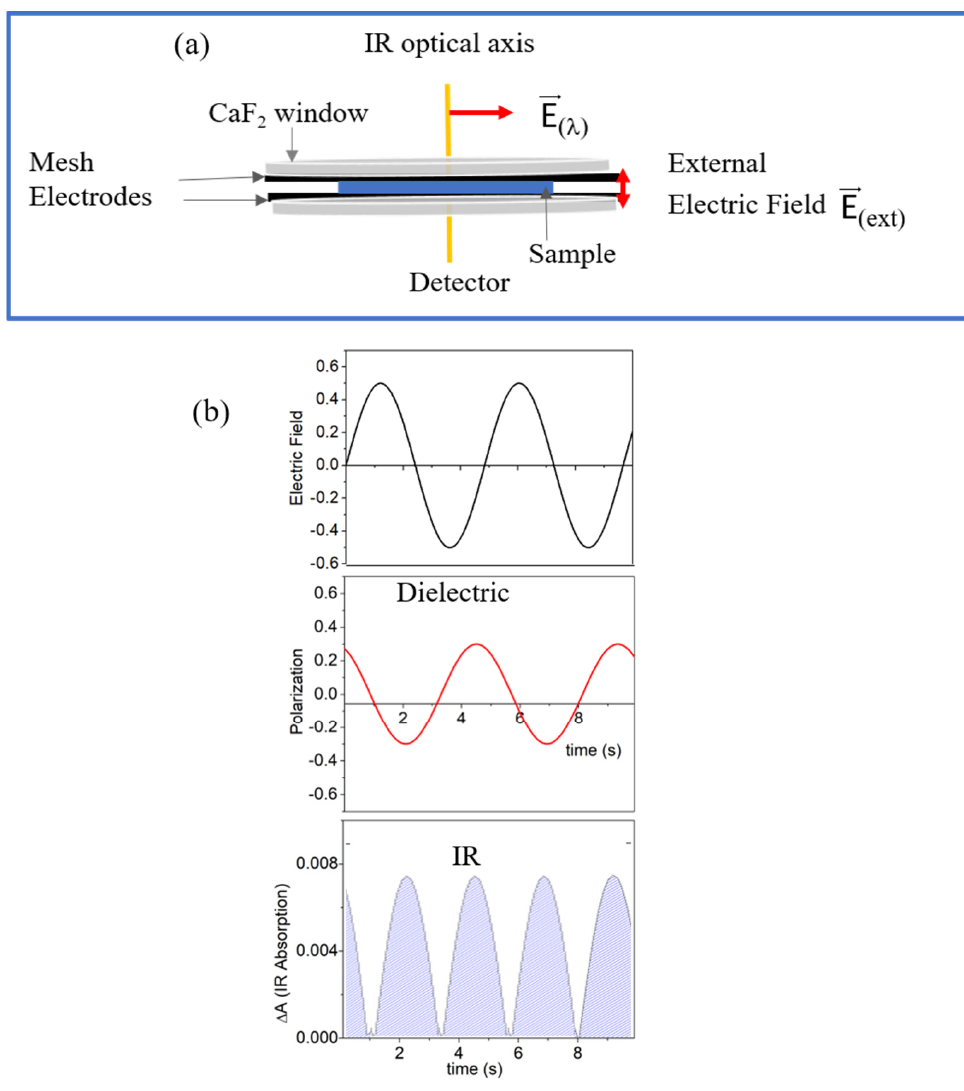
Figure 3. ( a ) Scheme of the sample cell: E ( λ ) is the E-vector of the IR-light and E (ext) is the external electric field applied to the sample; ( b ) orientation polarization as measured by dielectric and IR spectroscopy in the second harmonic of the modulated absorption.